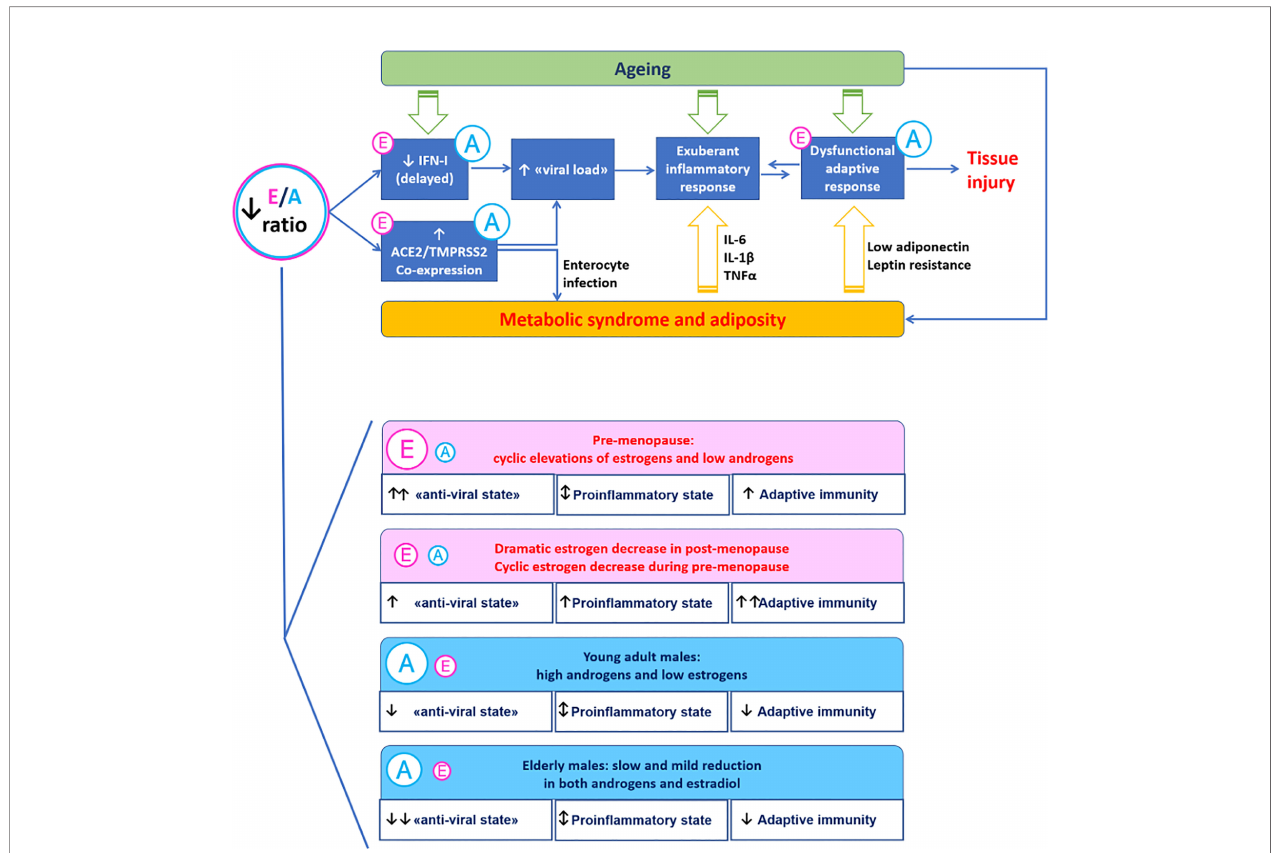
FIGURE 1 | A mechanistic model for the immunoendocrinology of COVID-19. Differences in estrogen to androgen balance due to ageing and gender may modulate SARS-CoV-2 entry factors ACE2 and TMPRSS2 involved in virus-host interaction. Estrogen promote the “ anti-viral state ” induced by interferon type I (innate immunity) and the development of anti-SARS-CoV-2 speci fi c responses (adaptive immunity). The proin fl ammatory milieu associated with excess visceral adiposity promotes SARS-CoV-2 infection and may be directly involved in the infection trough the enterocyte-adipose tissue